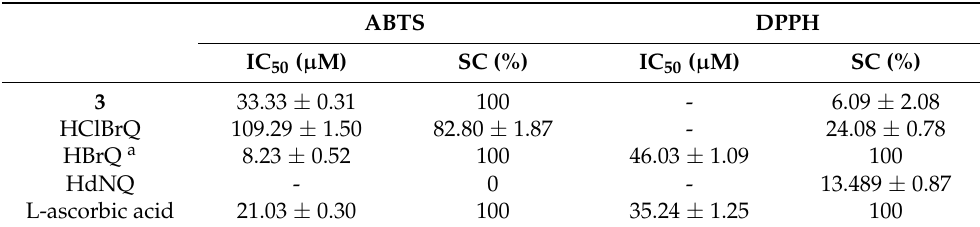
Table 6. ABTS and DPPH radical scavenging activity (IC 50 in µ M; and SC% for 200 µ M antioxidant concentration) for complex 3 , free ligands and L-ascorbic